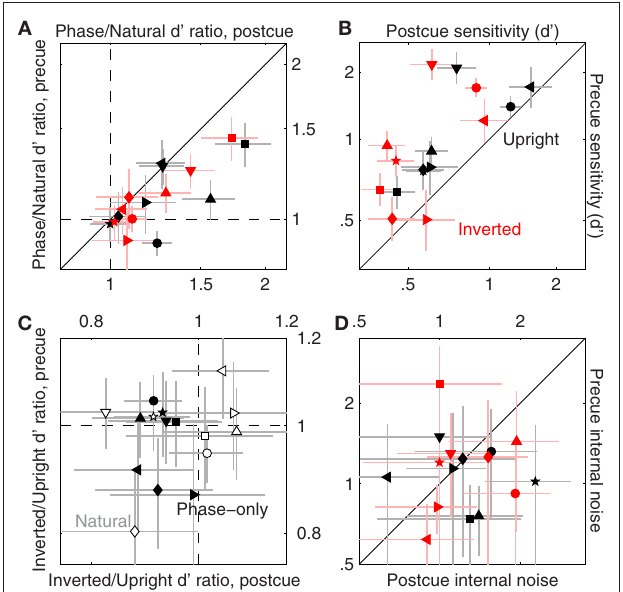
Figure 9 | Comparison between sensitivity to natural and phase-only images. (A) Plots the ratio between d ′ for phase-only images and d ′ for natural (unmanipulated) images, from precue trials ( y axis) versus postcue trials ( x axis). Dashed lines indicate unity ratios. (B) Plots d ′ for phase-only images, from precue trials ( y axis) versus postcue trials ( x axis); (D) plots internal noise in the same way. (C) Plots the ratio between d ′ for inverted images and d ′ for upright images, from precue trials ( y axis) versus postcue trials ( x axis) and for both the original images (open) and the phase-only